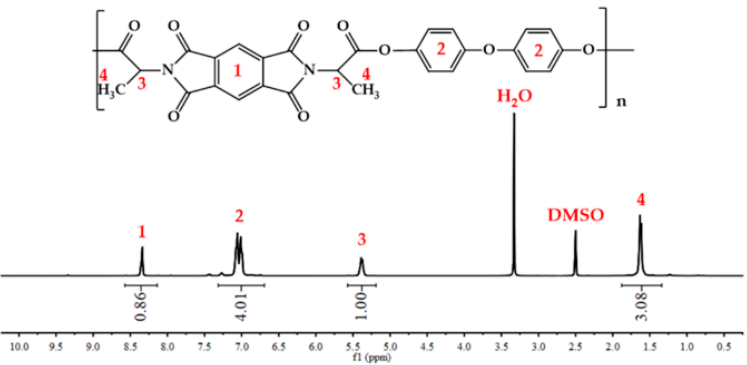
Figure 3. Representative 1 H NMR spectrum of PEI3a.